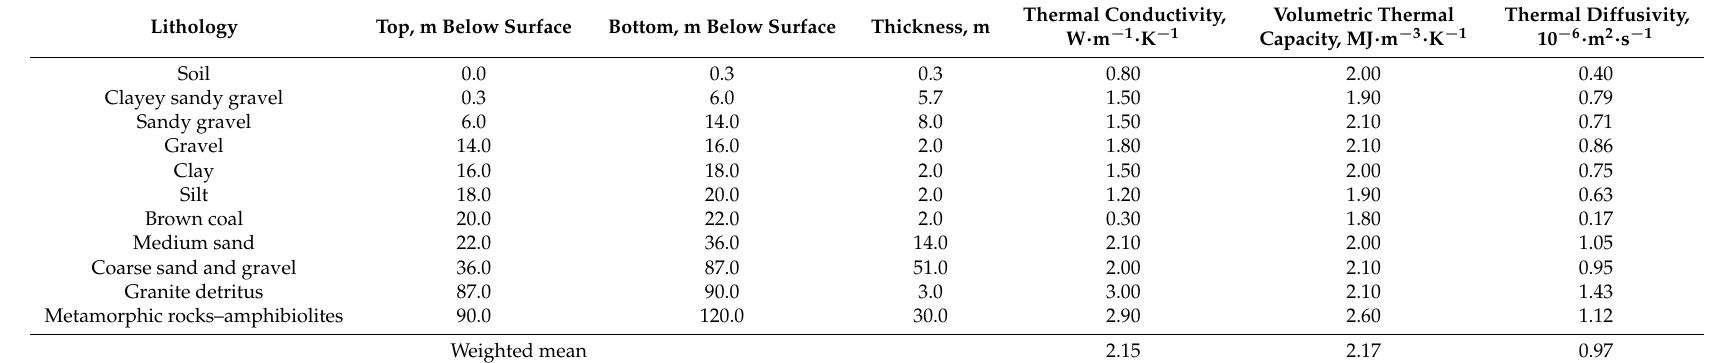
Table 1. Lithological profile of borehole in ˙Zar ó w, Poland.